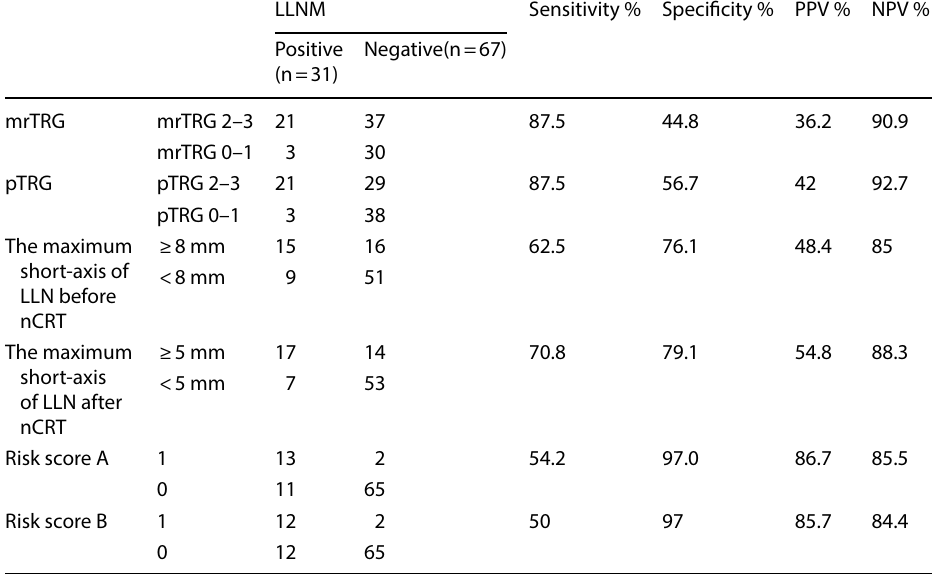
Table 4 The sensitivity, specificity, PPV and NPV of mrTRG, pTRG and the maximum short-axis before and after nCRT